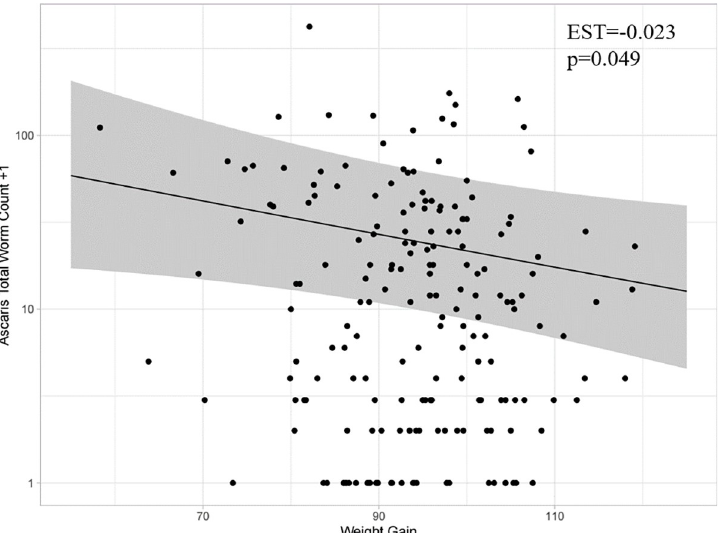
Fig 5. The relationship between Ascaris suum total worm counts (log scale) and weight gain (week 0–14) estimated using a generalised additive model (GAM) (n = 195). The estimate is shown by solid black line and 95% CI are shown in grey shading. Individual data points have been overlaid for reference (black dots), with a constant of 1 added before log transformation for the purposes of visualization only. Inset are the estimate (EST) and p-value generated using a generalised linear mixed model (GLMM) assuming that the relationship is